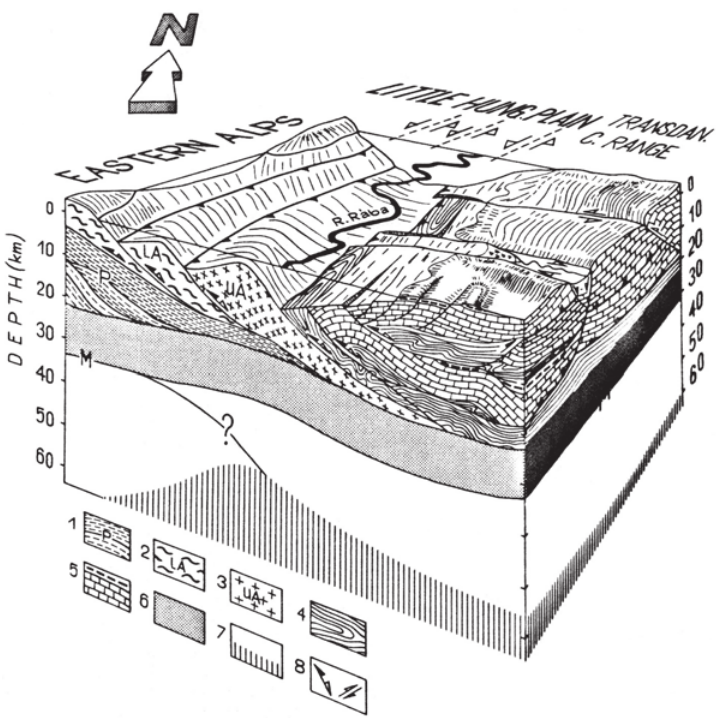
Fig. 3. Block diagram to illustrate the mechanism of lithospheric extension in the Little Hungarian Plain, western part of the Pannonian Basin. Note that there is no vertical exaggeration and block edges are about 100 km (front) and 80 km (side) long. Legend: 1 = HP/LT metamorphic rocks of the Penninic (P) nappes; 2 = medium- to high- grade metamorphic rocks of the lower Austroalpine nappes represented by the Wechsel series in this area; 3 = low- to medium-grade metamorphic rocks of the upper Austroalpine nappes represented by the Graz Paleozoic in this area; 4 = late Paleozoic low-grade metamorphic rocks of the TCR; 5 = Jurassic and Triassic of the Transdanubian Central Range (TCR); 6 = ductile lower crust and the Moho discontinuity; 7 = lower lithosphere and asthenosphere; 8 = thrust fault and its reactivation as normal fault and strike slip fault, respectively (Horváth,